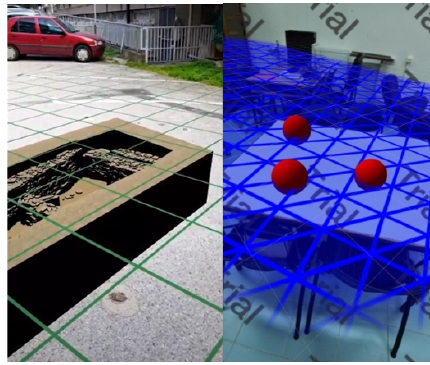
Figure 4 : Markerless Augmented Reality example.